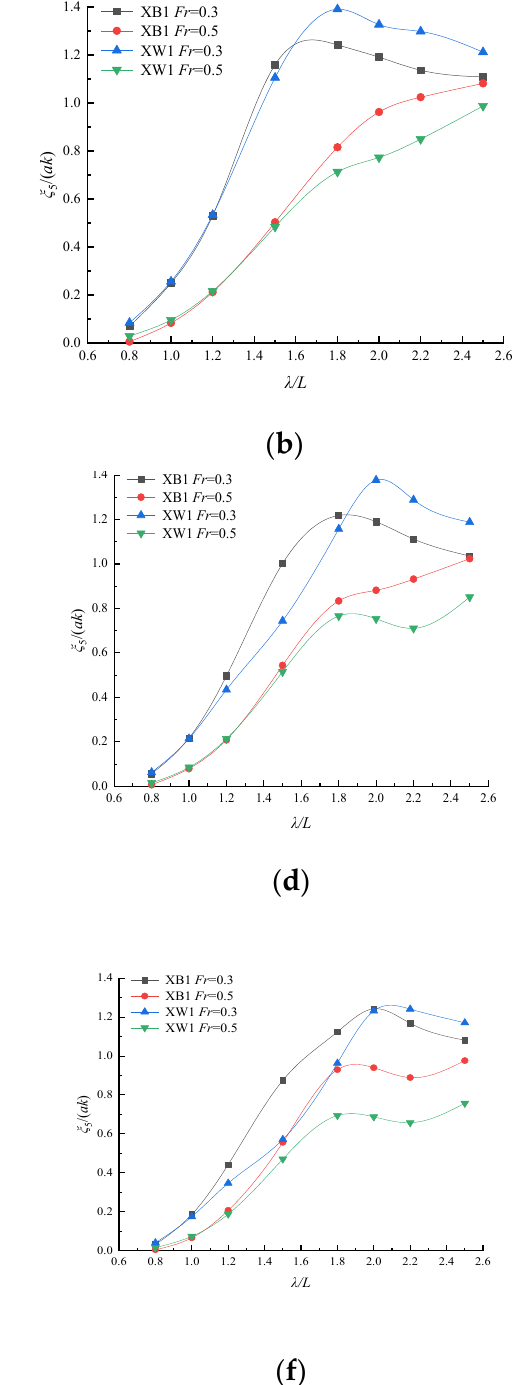
Figure 7. Time histories of heave response, pitch response and resistance of hull ( H = 0.12); ( a ) Heave motion ( b ) Pitch motion ( c ) Resistance of hull.